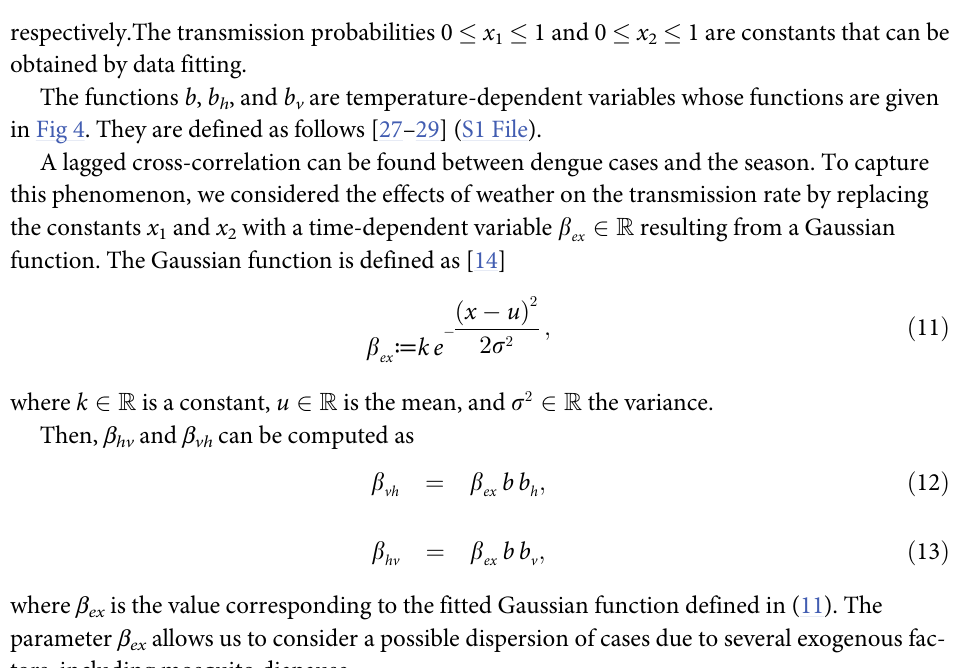
Fig 3. Conceptual diagram of the SIR-SI model. S : susceptible; I : infected/infectious; R : recovered; v : vector; β host-to-vector transmission rate; γ : recovery rate; μ v : vector mortality rate.